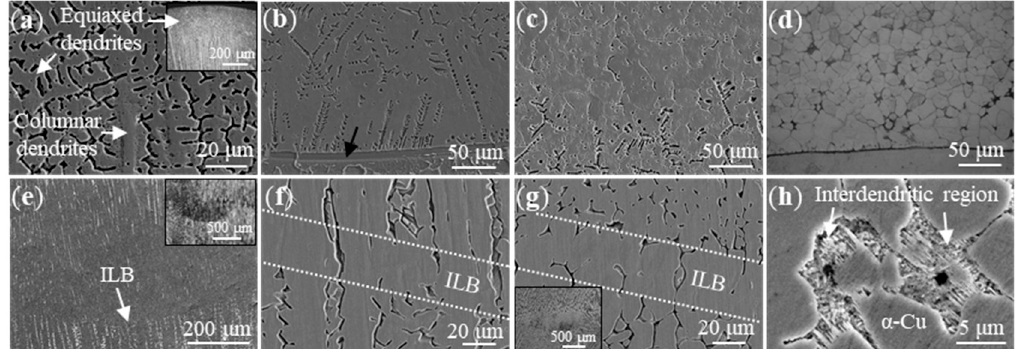
Figure 4. The microstructure of some characteristic regions (Y-Z plane): ( a ) the transition of microstructure from C2 sample, ( b ) the bottom region of C2 sample, ( c ) the dendrites transformed to cellular structure in C2 sample, ( d ) the bottom region of U3 sample, ( e ) interlayer bands (ILB region) in C2 sample, ( f ) ILB of C2 sample, ( g ) ILB of U3 sample, ( h ) interdendritic region in magnification from U3 sample.